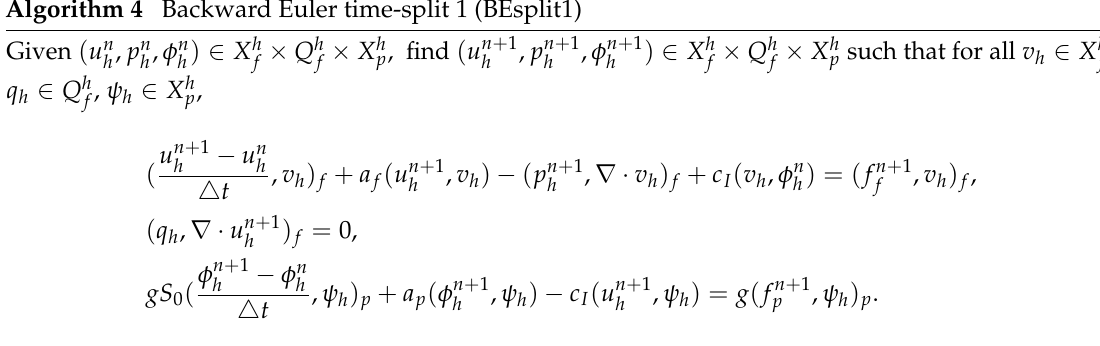
Algorithm 4 Backward Euler time-split 1